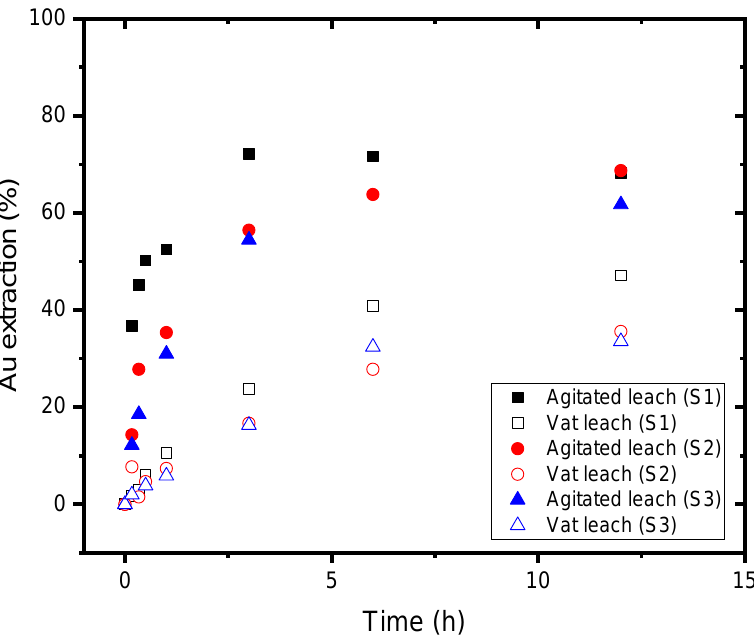
Figure 12. Comparison of Au extraction between agitated cyanide leach and vat cyanide leach for Sample 1 (S1), Sample 2 (S2), and Sample 3 (S3) (30% solids, −300 + 150 µm PSD, 26 °C).